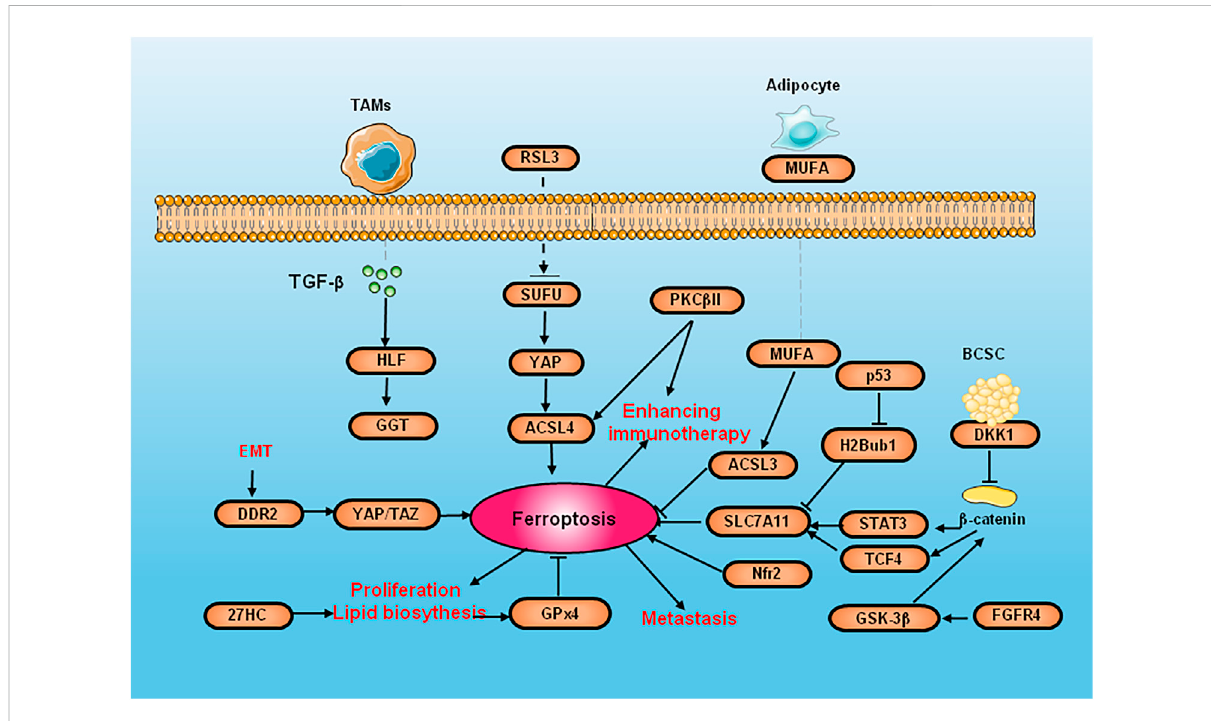
FIGURE 2 The diagram of cell signaling pathways and molecules of ferroptosis in breast cancer. SUFU deletion increase the ferroptosis by activated by RSL3 via ACSL4. PKC β II activate ACSL4 to induce lipid peroxidation and improves the ef fi cacy of immunotherapy. DKK1 inhibit their stem cell properties. Because CSCs are highly sensitive to ferroptosis, DKK1 induces SLC7A11 increasing and promote the development of metastase og CSC. DMOCPTL inhibit GPX4 to induce ferroptosis by EGR-1. 27HC exposure induce the overexpression of GPX4 to inhibit ferroptosis and increase the proliferation and metastasis. The upregulation of DDR2 elicits ferroptosis to recurrent breast cancer through the Hippo pathway. EMT induce DDR2 upregulation to active ferroptodis by regulating YAP/TAZ. GSK-3 β promoting erastin-induced ferroptosis by blocking Nrf2. p53 reduces the expression of SLC7A11 by inhibiting H2Bub1. FGFR4 suppress GSH synthesis and ef fl ux of Fe 2+ through β -catenin/TCF4/SLC7A1 signaling